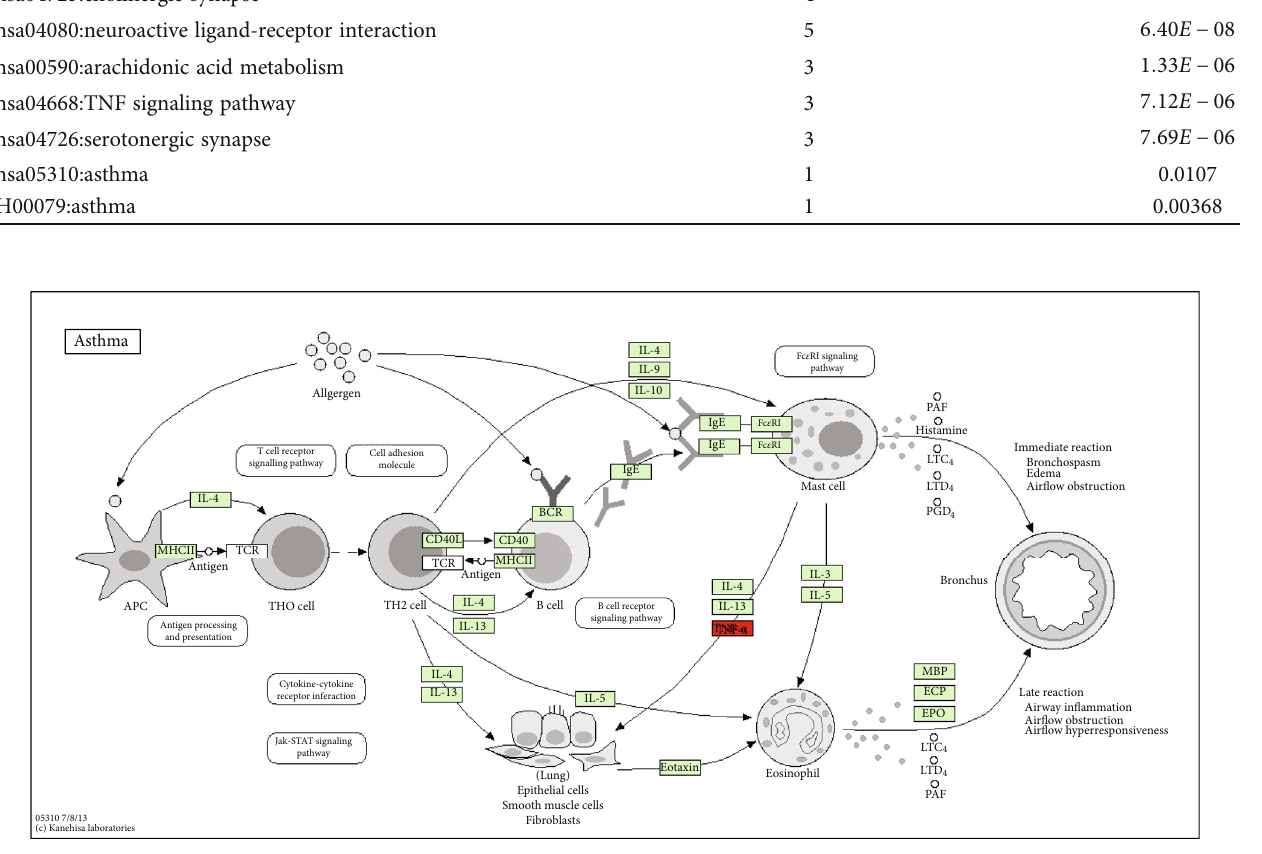
Figure 5: The pathway map of